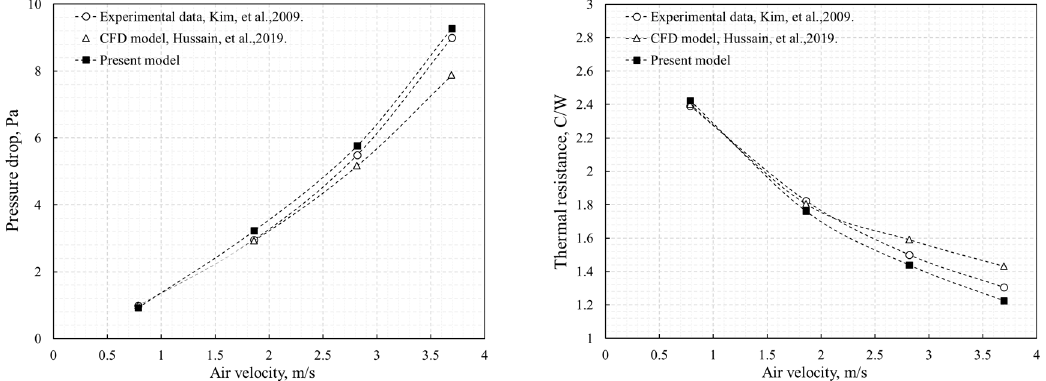
Figure 6. Comparison of pressure drops and thermal resistances of heat sink at different air velocities